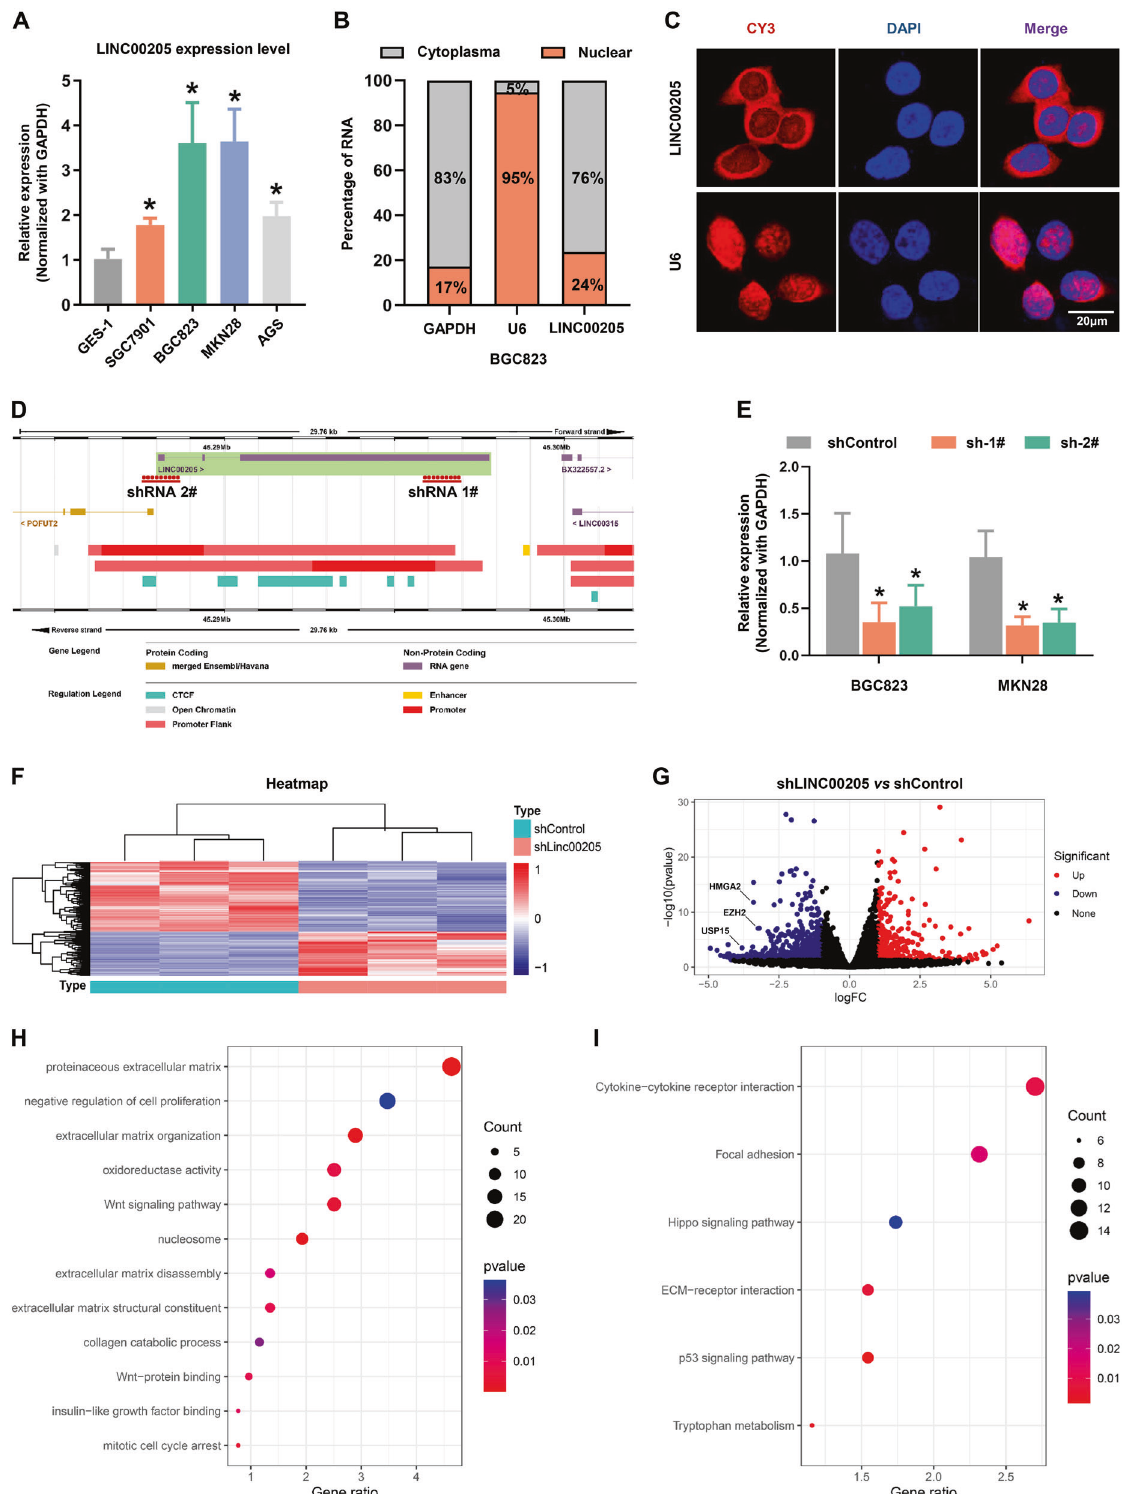
Fig. S6D – F). These results suggested that miR-26a was a potential binding target of LINC00205. To further delineate the downstream signaling mechanisms responsible for the tumorigenesis effects of LINC00205, computational-analyzes identi fi ed that LINC00205 and